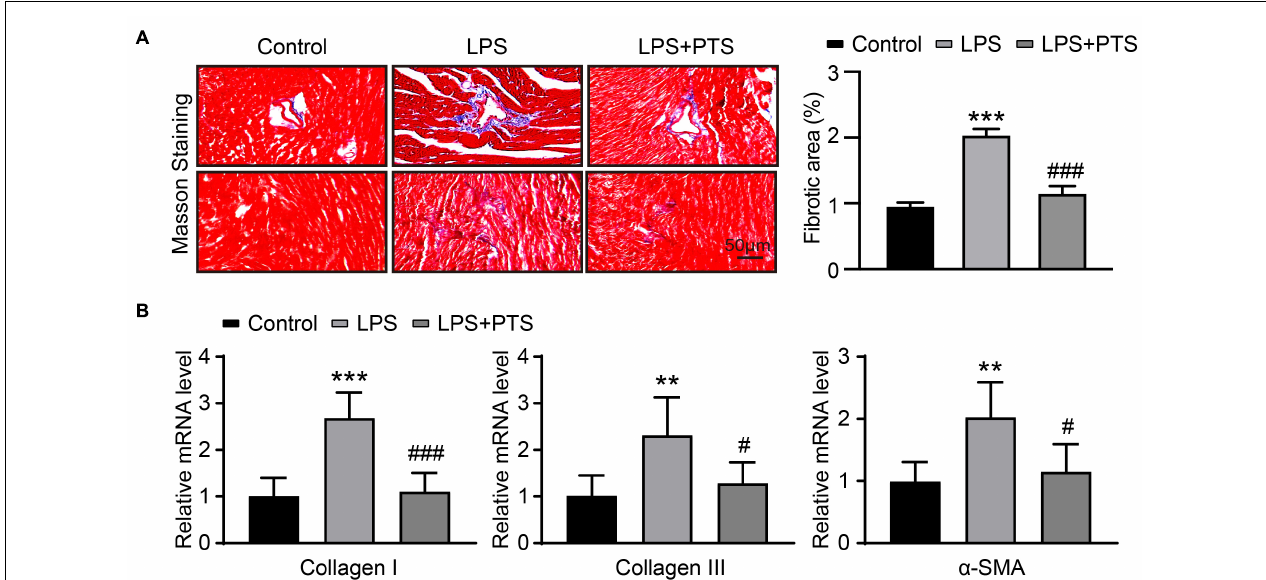
FIGURE 3 | PTS inhibits fibrosis in the hearts of mice with LPS-Induced septic mice. (A) Representative of Masson from control group, LPS group, and LPS + PTS group on the left and quantitative data are shown on the right ( n = 6). (B) The mRNA levels of IL-1 α , Il-1 β , IL-6, and MCP-1 in heart tissue from control group, LPS group, and LPS + PTS group were detected by qPCR ( n = 6). ** P < 0.01, *** P < 0.001 control vs. LPS, # P < 0.05, ### P < 0.001 LPS vs. LPS +